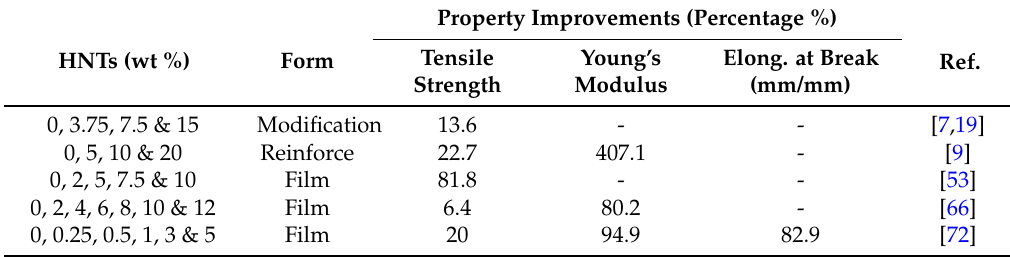
Figure 12. Tensile strength and Young’s modulus of PVA-HNT films with different amounts of HNTs [66]. Table 4. HNT-based PVA composites with the range of HNTs loading and the intended/achieved target mechanical properties for each composition.